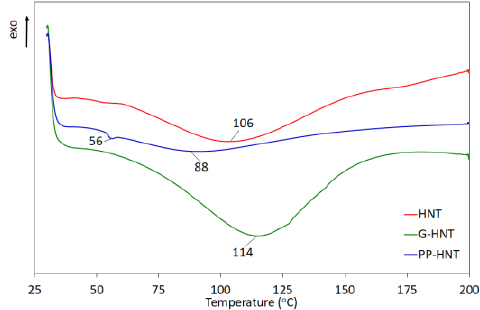
Figure 5. DSC curves of pure and modified HNT.